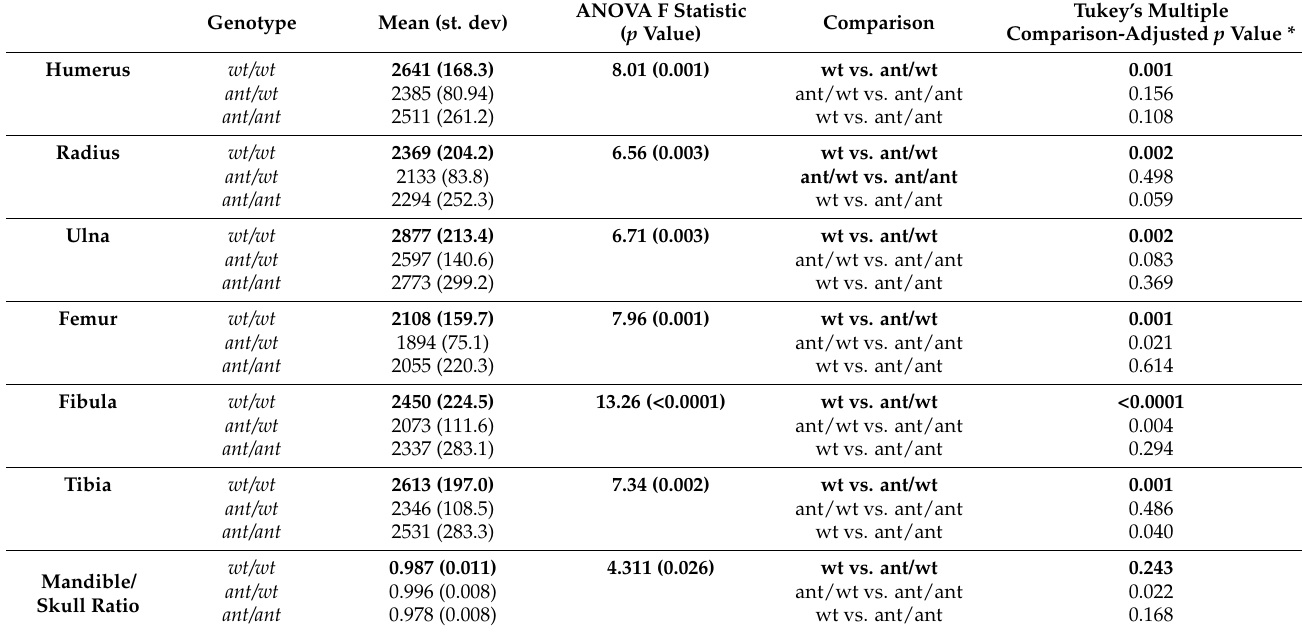
Table 2. Statistical Analysis of Skeletal Elements.